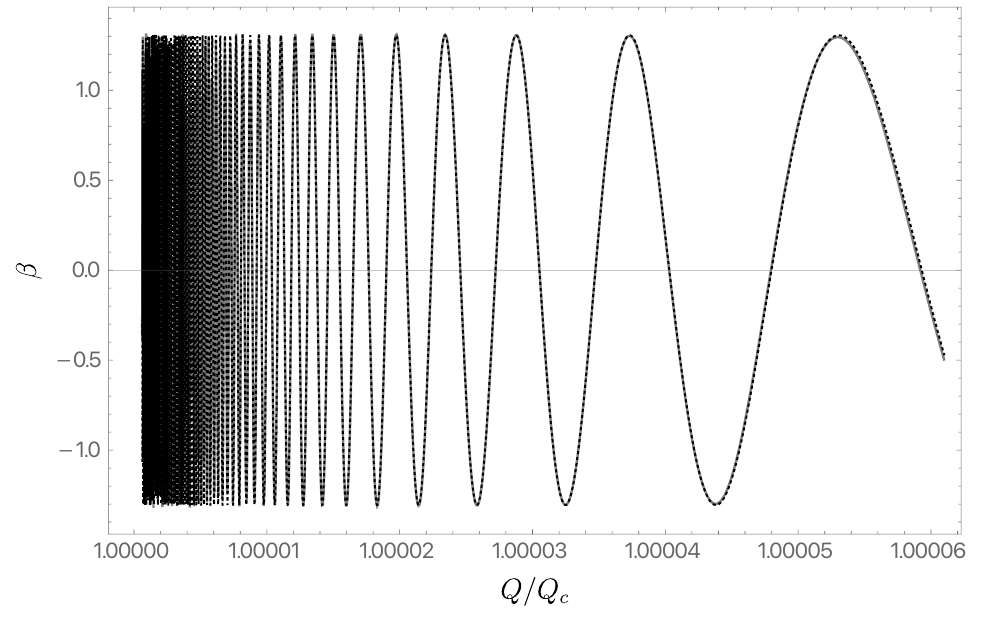
Figure 3 . The parameter β determining the Kasner exponents as a function of the black hole charge Q for α = 1 , q = m, mM = 0 . 5 . The solid grey line is the numerical solution and the dotted black curve is a fit to (4.19). The scalar starts to condense at the critical charge m Q c = . 4942545